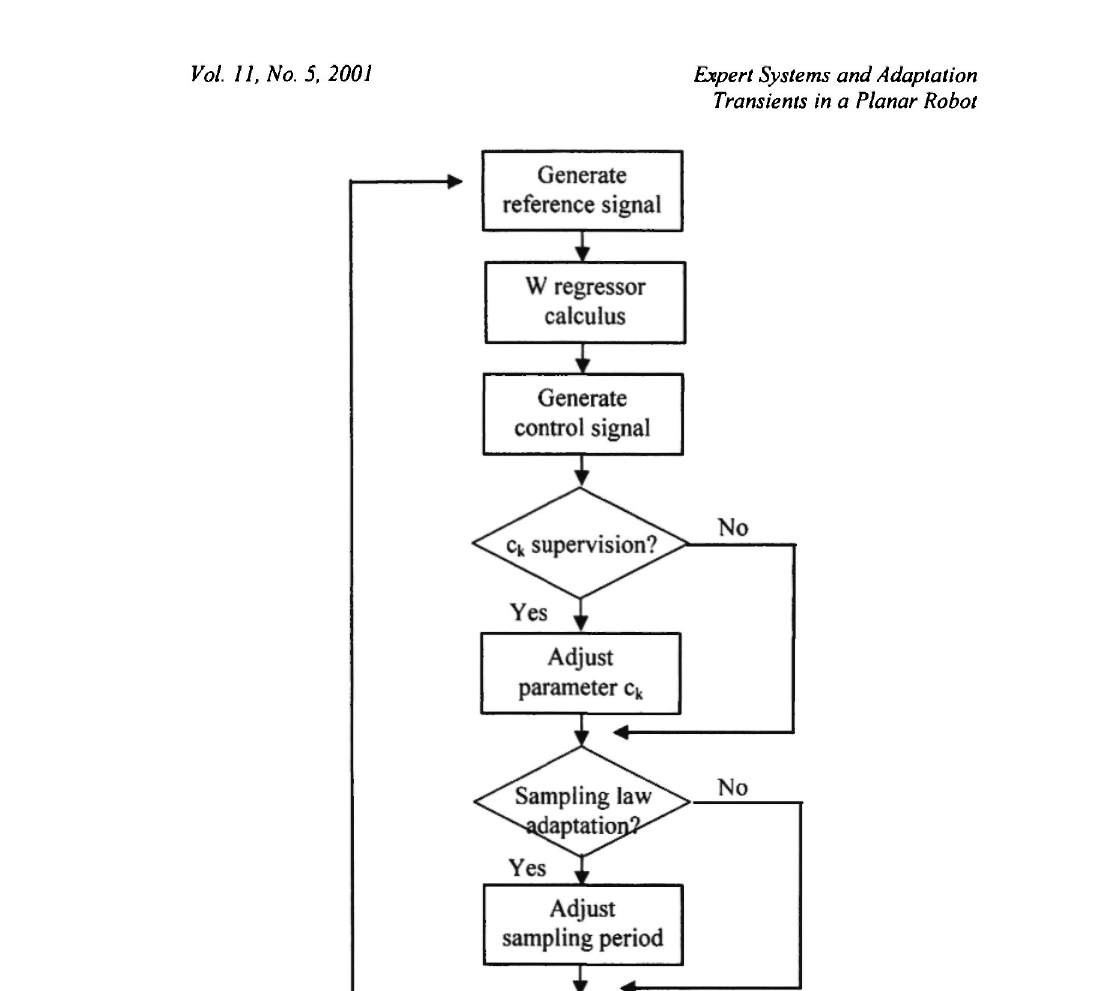
Fig. 2.6: Flow diagram for the expert